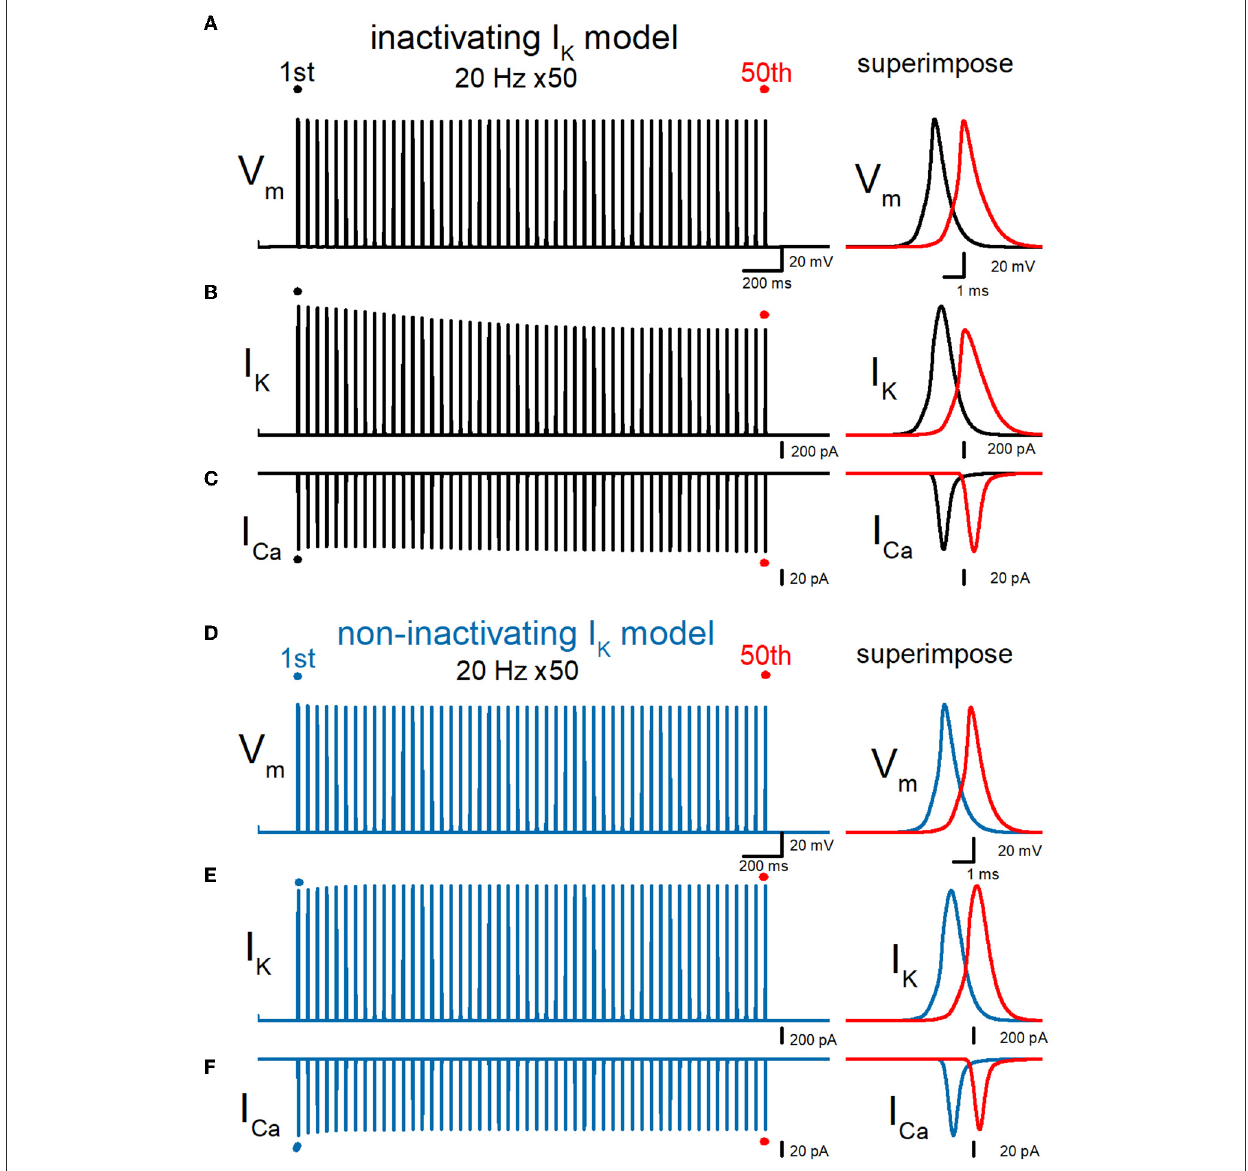
FIGURE7 Effects of repetitive stimuli on action potentials, axonal I K , and presynaptic I Ca with axonal K V 7 M-type K channels. (A) Simulated propagating action potentials at the mossy fiber bouton (V m ) elicited by repetitive stimuli of 50 times at 20Hz in the inactivating I K model implemented with the K V 7 M-type K channel model. (B) Axonal K + current elicited by the repetitive action potentials (I K ) in inactivating I K model. (C) Ca 2 + currents (I Ca ) elicited by axonal action potentials during the repetitive stimuli in inactivating the I K model. (D) Simulated propagating action potentials at the mossy fiber bouton (V m ) elicited by repetitive stimuli of 50 times at 20Hz in the non-inactivating I K model. (E) Axonal K + current elicited by the repetitive action potentials (I K ) in the non-inactivating I K model. (F) Ca 2 + currents (I Ca ) elicited by axonal action potentials during the repetitive stimuli in the non-inactivating I K model. In each right panel, the responses to the 50th stimulus (red traces) were superimposed with that elicited by the 1st stimulus (black or blue traces) for